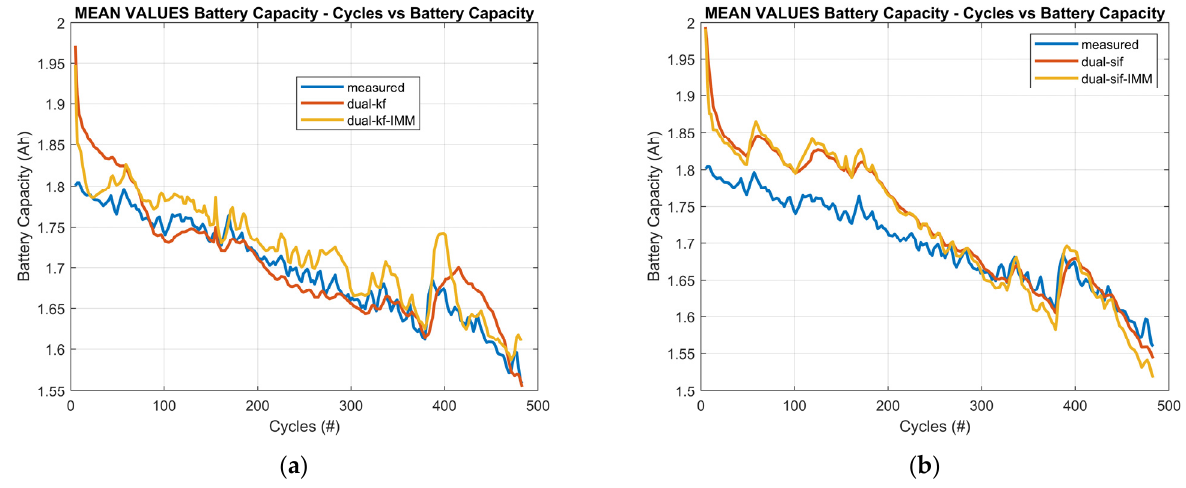
Figure 11. ( a ) Dual-KF and dual-KF-IMM battery capacity estimates. ( b ) Dual-SIF and dual-SIF-IMM battery capacity estimates.